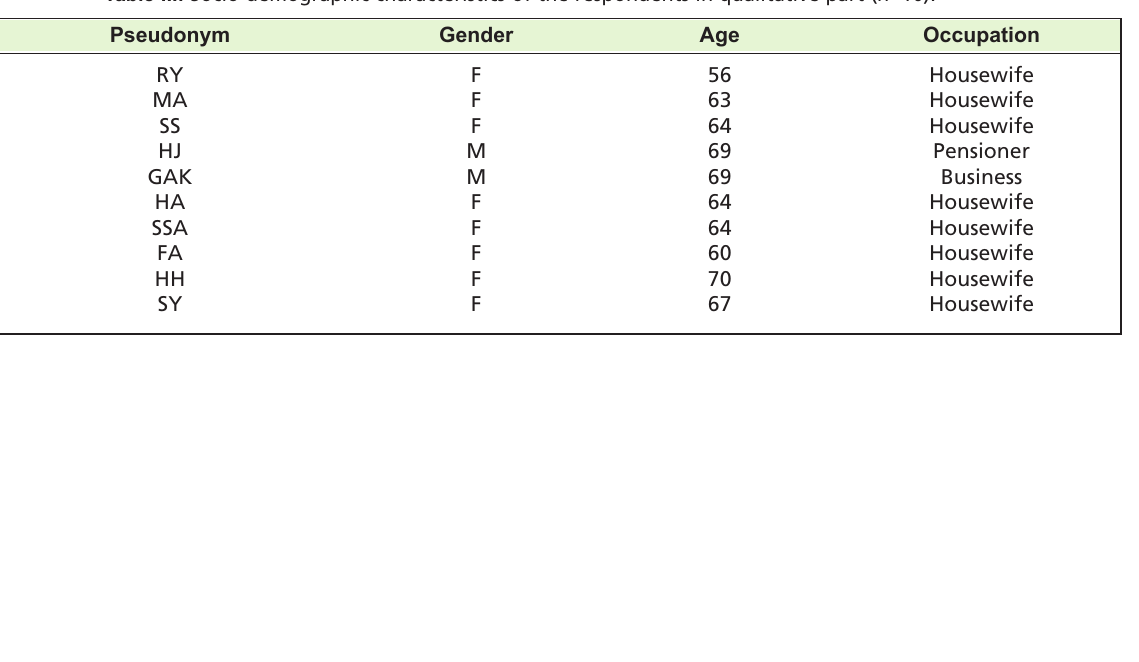
Table III: Socio-demographic characteristics of the respondents in qualitative part